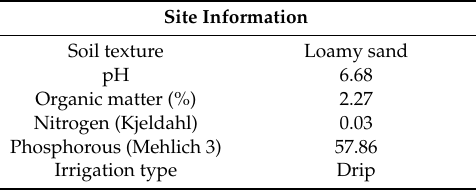
Table A1. Site information and soil physiochemical properties during the 2016 growing